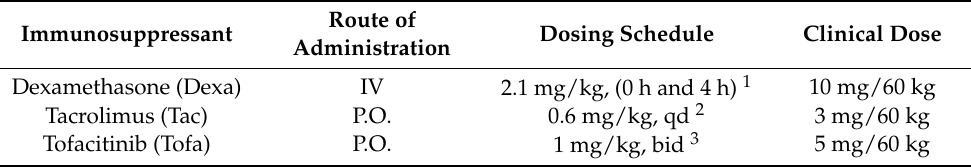
Table 1. Route of Administration and Dosing Schedules for Immunosuppressants. Route of Immunosuppressant Dosing Schedule Clinical Dose Administration Dexamethasone